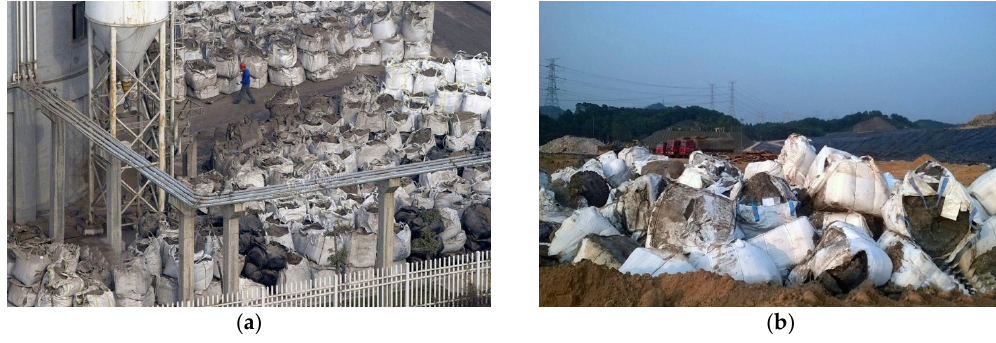
Figure 3. ( a ) Fly ash in the open area of a waste-to-energy (WTE) incineration plant and ( b ) Fly ash dumps open without curing. (Photos source: [13,46]).